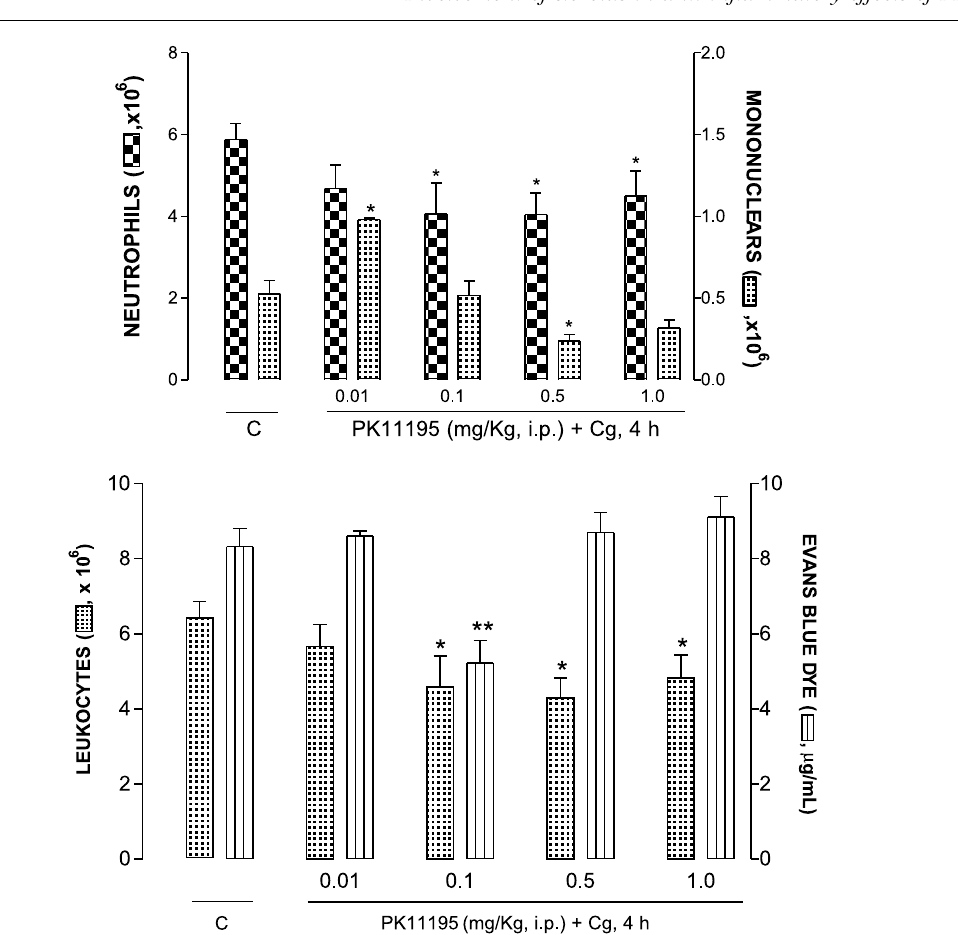
FIG. 2. Effects of different doses of PK11195 (0.01 (cid:1) / 1.0 mg/kg, i.p.) administered 1 h prior to carrageenan (Cg, 1%/cav.), on the early (4 h) phase of the mouse pleurisy induced by Cg. Leukocytes and exudation levels. Inset: Mononuclear and neutrophil cells, under the same conditions. C, Control responses in animals only treated with Cg. Each column represents the mean of four to six animals, and the vertical bars represent the standard error of the mean. * p B / 0.05 and ** p B /